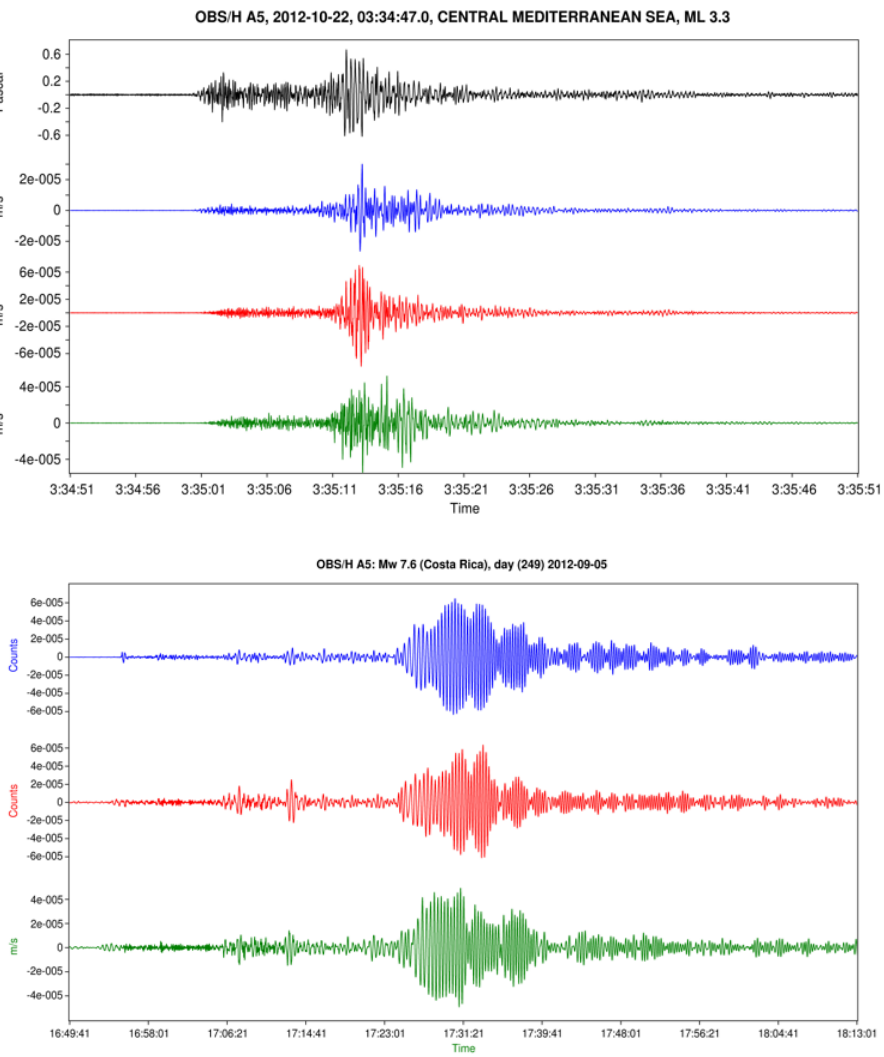
7.6, Costa Rica) on the right, W